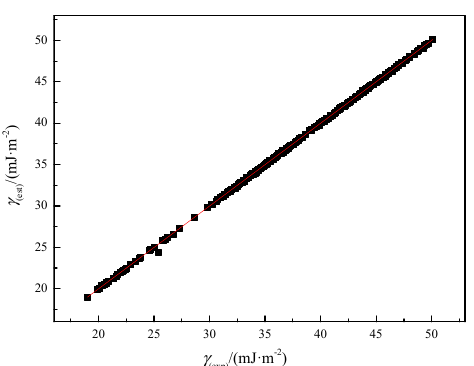
Figure 4. Plot of surface tension γ (est) against γ (exp) for various ionic and molecular liquids (see Table S6). γ (est) = 1.0009 γ (exp) − 0.03643; r 2 = 0.999; sd = 0.10. For ILs sharing the same anions (Table 1 and Table S6), n D decreases as the length of the Table 3. Molar refraction ( R m ), mean molecular polarizability ( α p ), and estimated surface tension alkyl chain in the cations increases. Refractive index correlates with dipole moment